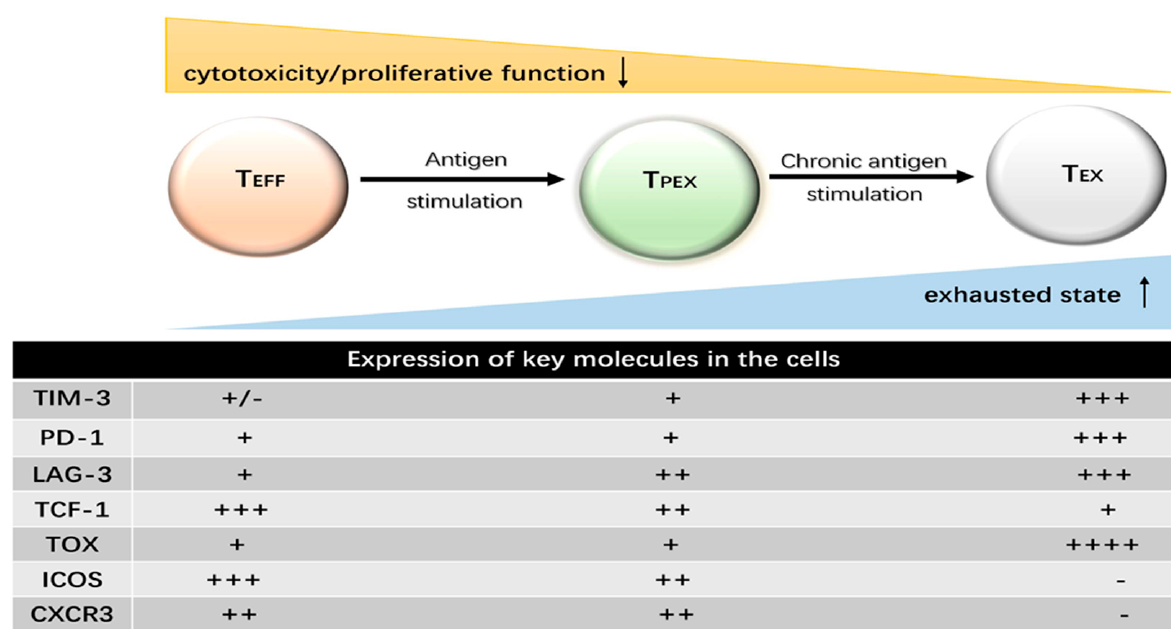
Figure A1. Exhausted T cells have been induced by many chronic antigen stimulations, The